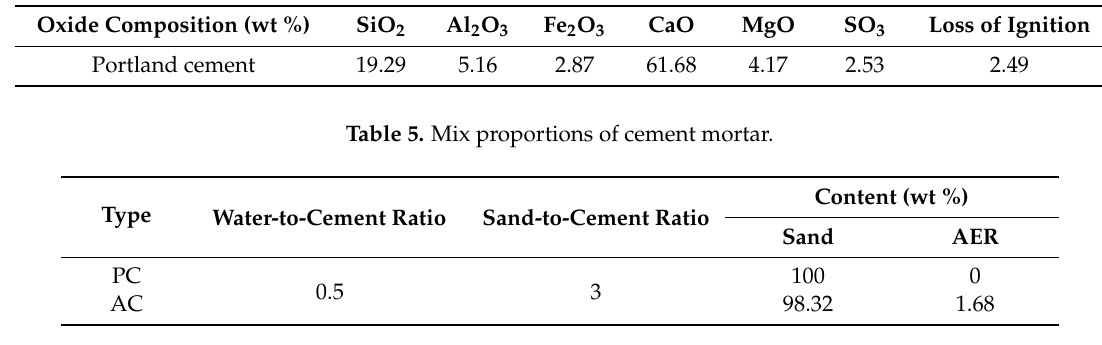
Table 4. Oxide composition of type 1 Portland cement.